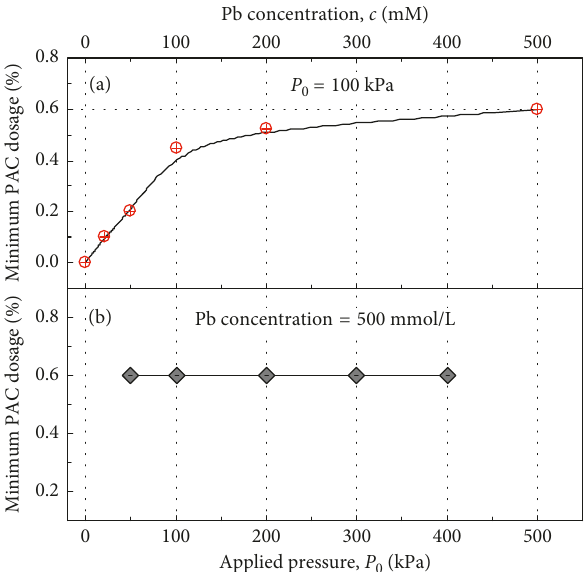
Figure 6: (a) The minimum PAC dosage of backfills when exposed to Pb(NO 3 ) 2 solutions with various concentrations, and (b) the minimum PAC dosage of backfills permeated with 500mM Pb out /EC in , (b) under various pressures.